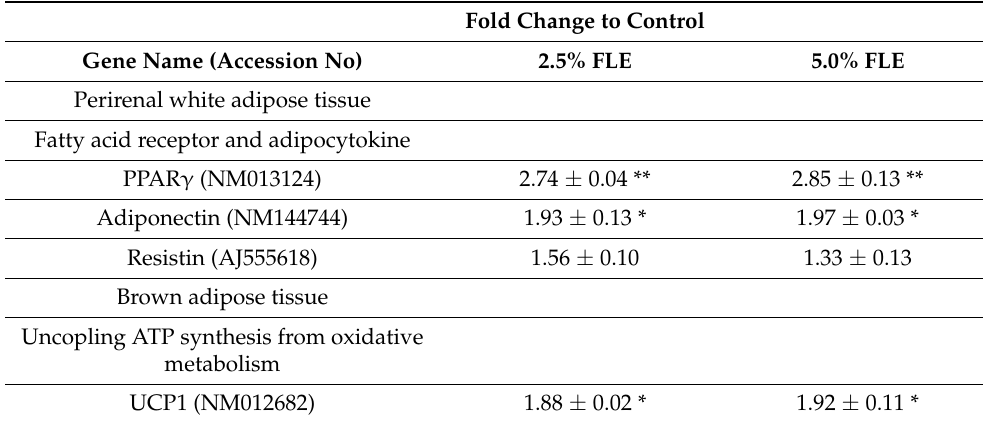
Table 4. Gene expression analysis in adipose tissue by real-time PCR after four weeks of HFD feeding. Fold Change to Control